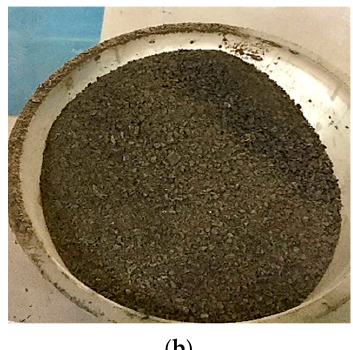
( c ) Figure 1. ( a ) Periwinkle shells; ( b ) crushed periwinkle shells; ( c ) laboratory ball milling crusher with steel balls. 2.2. Method—Mix Design and Batching. In this study, the batch proportioning of the constituent materials for the hollow sandcrete blocks was carried out by weighing three (3) batches in the laboratory. A con- stituents design mixture of 1:6 (cement: aggregate) was adopted at a constant water–ce- ment (w/c) ratio of 0.35. The mix ratio of 1:6 was adopted as it is similar to what is gener- ally employed by most local sandcrete blocks industry in Ogun state, and to achieve a realistic onsite simulation. The first batch was the control samples comprised of sand and stone dust, without crushed periwinkle shell (CPWS). The second batch involved the use of the three constituents: sand, stone dust and crushed periwinkle shell (CPWS). River sand was partially replaced by the CPWS using percentage replacement levels of 5, 10, 15 and 20% with a constant amount of cement, w/c ratio and stone dust. Meanwhile, the third batch also used all the three constituent materials; that is river sand, stone dust and crushed periwinkle shell (CPWS). In the third batch, the CPWS was used to partially re- place stone dust in the sandcrete mixes using the same percentage replacement levels of 5, 10, 15 and 20% while the river sand, cement and w/c ratio remained constant. The min- imum design strength expected to be achieved was 2.5 N/mm 2 . Table 1 depicts the adopted mix proportion in the production of the hollow sandcrete block samples.